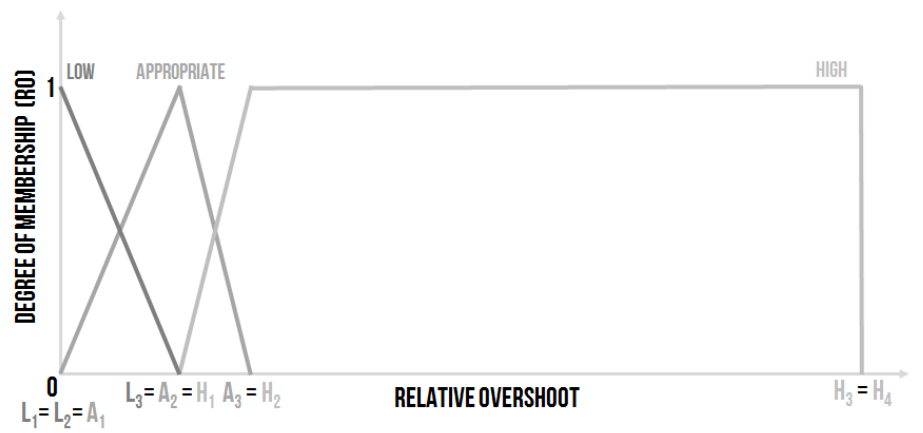
Figure 6. The shape of the membership functions of the linguistic values for the input linguistic variable Relative Overshoot (RO)–design no.